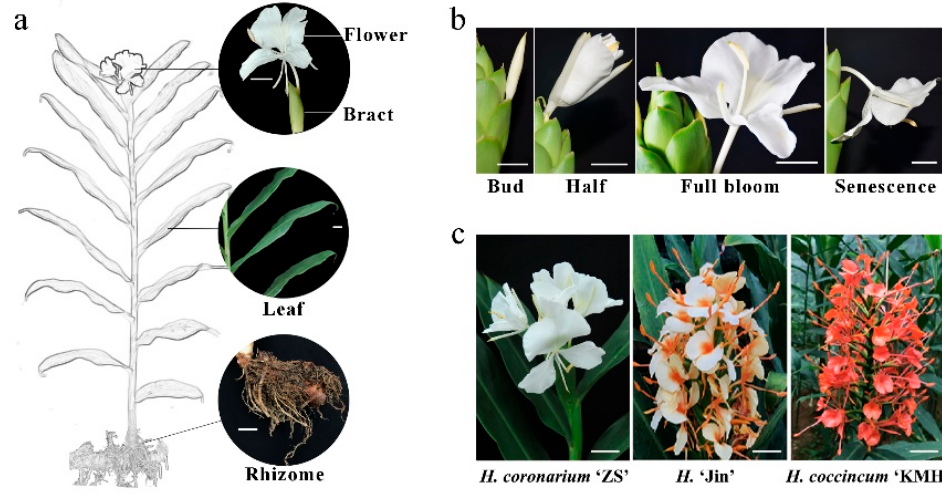
Figure 3. A pictorial view of labeled H . coronarium tissues. ( a ) Figure representation of H . coronarium flower, bracts, leaves, and rhizome; ( b ) figure illustration of different flower developmental stages (bud stage, half bloom, full-bloom and senescence stage); ( c ) pictorial representation of three different Hedychium accessions. Scale bar indicates 2 cm.